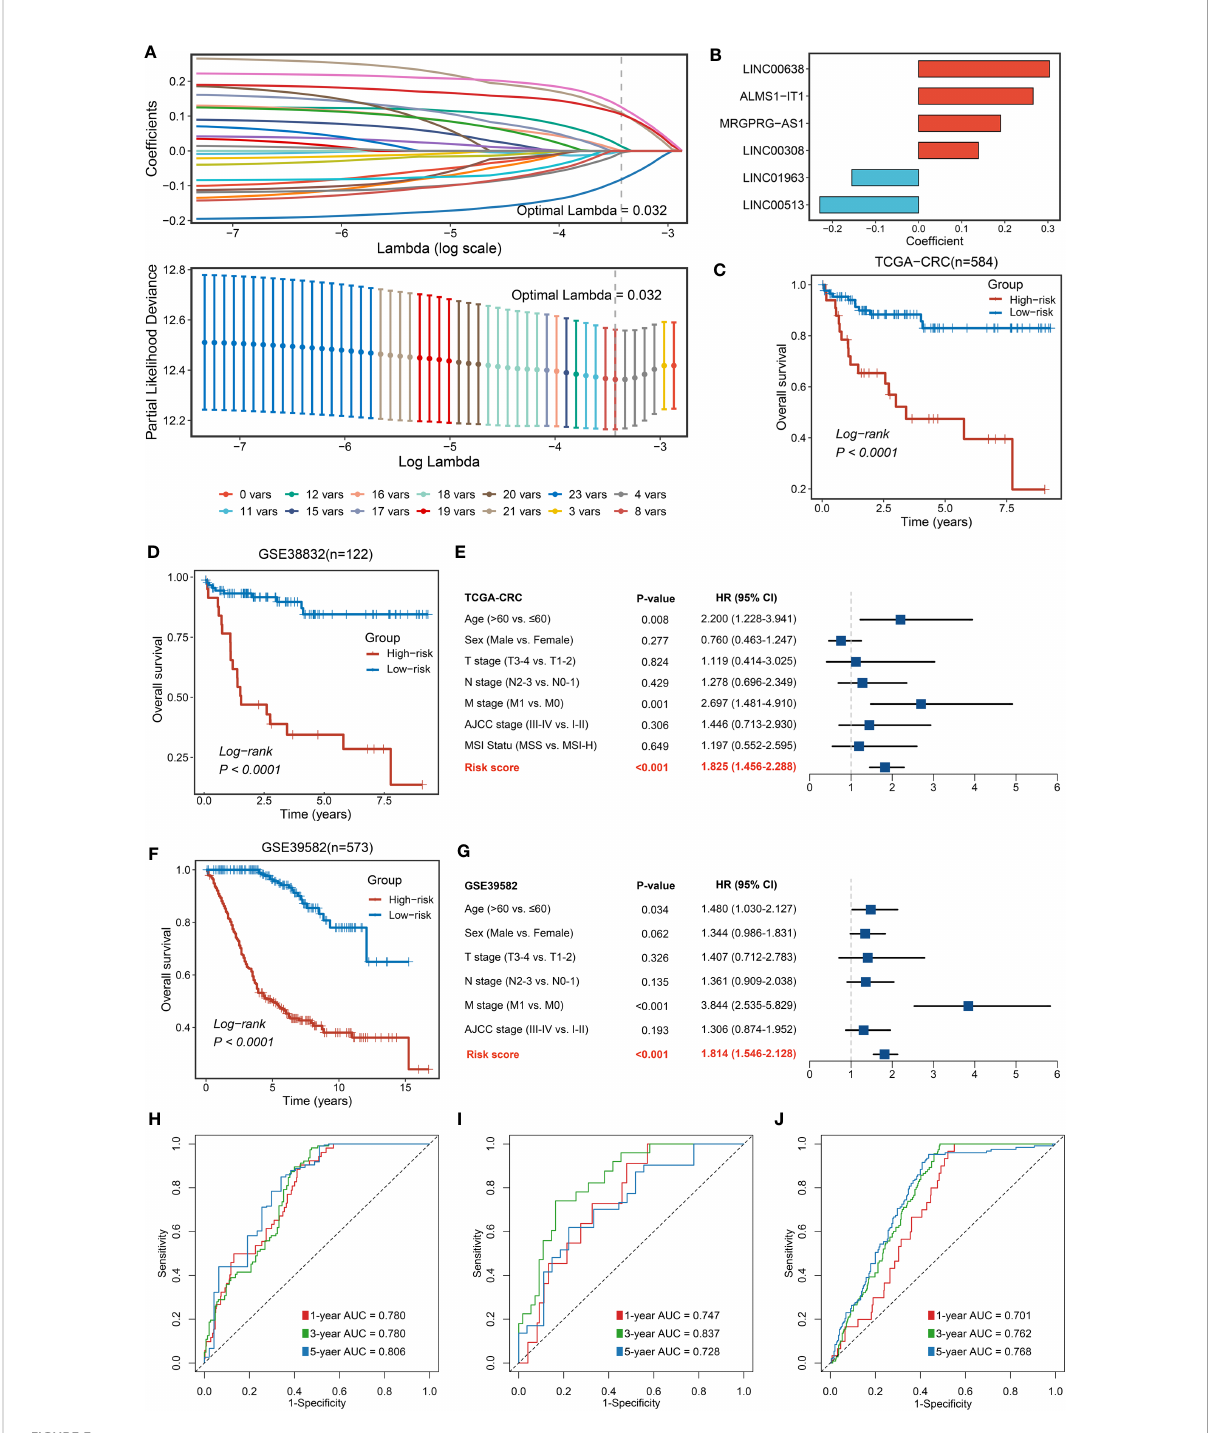
FIGURE 3 Construction and validation of NLncS. (A) Determination of the optimal lambda was obtained when the partial likelihood deviance reached the minimum value. (B) Univariate Cox regression was further performed to generate the key lncRNAs with non-zero coef fi cients and predictive values. LASSO coef fi cient pro fi les of the candidate lncRNAs for NLncS construction. (C, D, F) Kaplan – Meier curves of OS according to NLncS in TCGA-CRC (C) , GSE38832 (D) , and GSE39582 (F) . (E, G) Multivariable Cox regression analysis of NLncS in TCGA-CRC (E) and GSE39582 (G) . (H-J) Time-dependent ROC analysis for predicting OS at 1, 3, and 5 years in TCGA-CRC (H) , GSE38832 (I) , and GSE39582 (J)